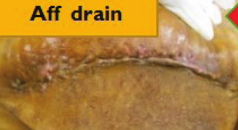
Figure 1. Follow up day 4 after cesarean section: wound dehiscence on surgical wound